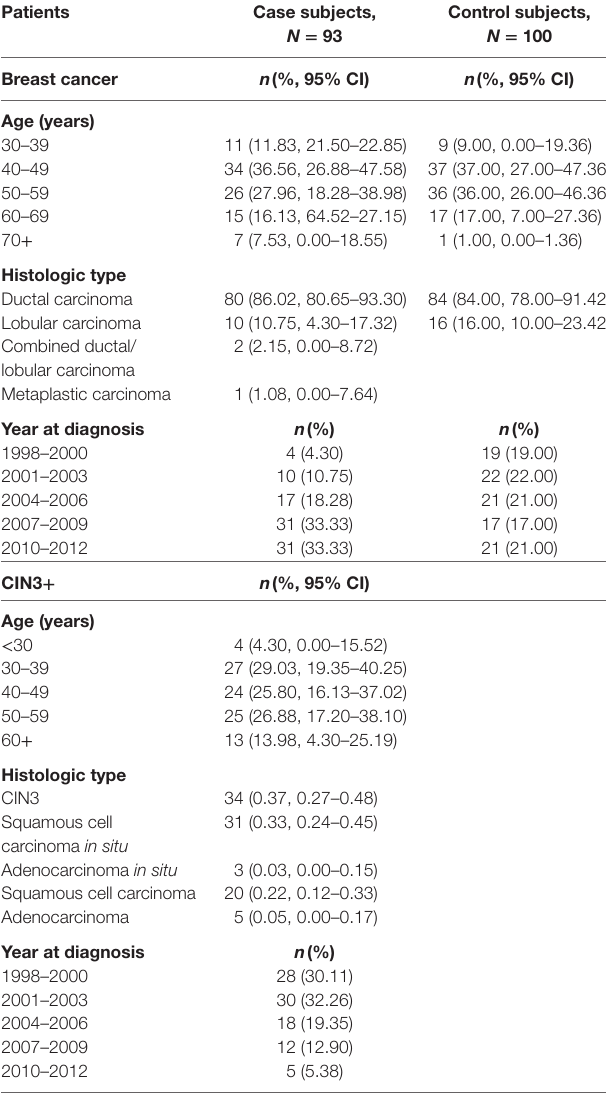
TaBle 1 | Characteristics of the study population ( N =